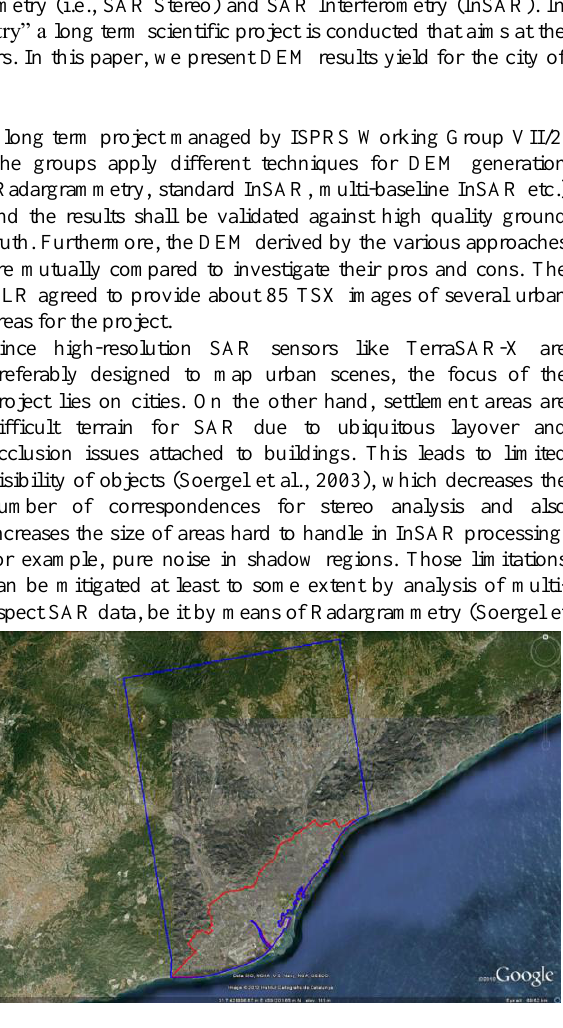
Figure 1. Test Site (Blue: Large Area, Red: Urban